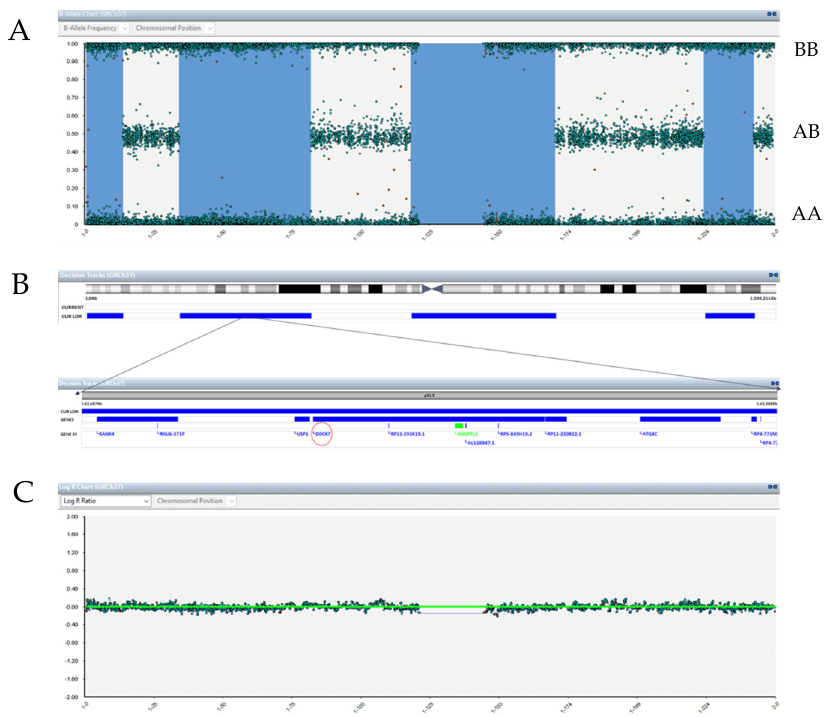
Figure 4. Details of maternal UPD by SNP array analysis of chromosome 1. ( A ) B-allele chart displayed four segments of chromosome 1 alternately homozygous (UPiD; shown in blue, no heterozygous SNPs, only AA and BB)) and heterozygous (UPhD; SNPs with AB genotype present) regions. ( B ) The DOCK7 gene (red circle) is located in p31.3, a region situated in one of the four homozygous segments. ( C ) Aneuploidy screening (Log R Ratio) did not show aneuploidies or CNVs > 10 Mb.